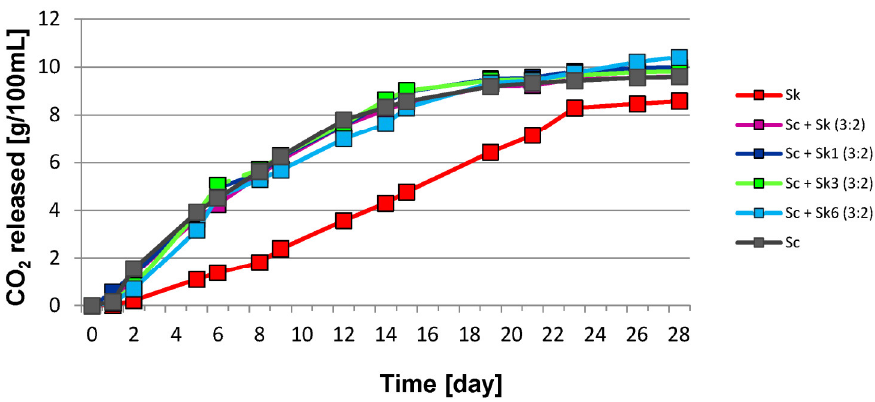
Figure 1. The kinetics of grape must fermentation with mixed cultures of Saccharomyces cerevisiae (Sc) and S. kudriavzevii (Sk) with an initial yeast ratio 3:2. Sk 1 , Sk 3 , Sk 6 : sequential inoculation of Sc followed Sk after one day, three days, six days.